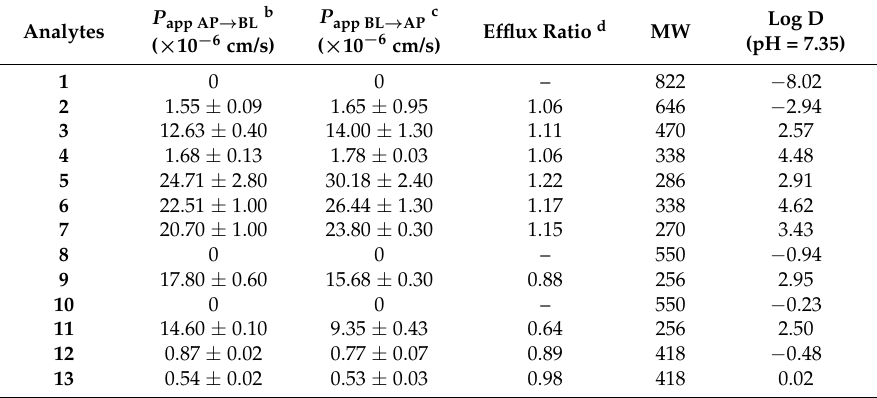
Table 1. The bidirectional P app values of compounds 1 – 13 in Caco-2 cell monolayer ( n = 3). a